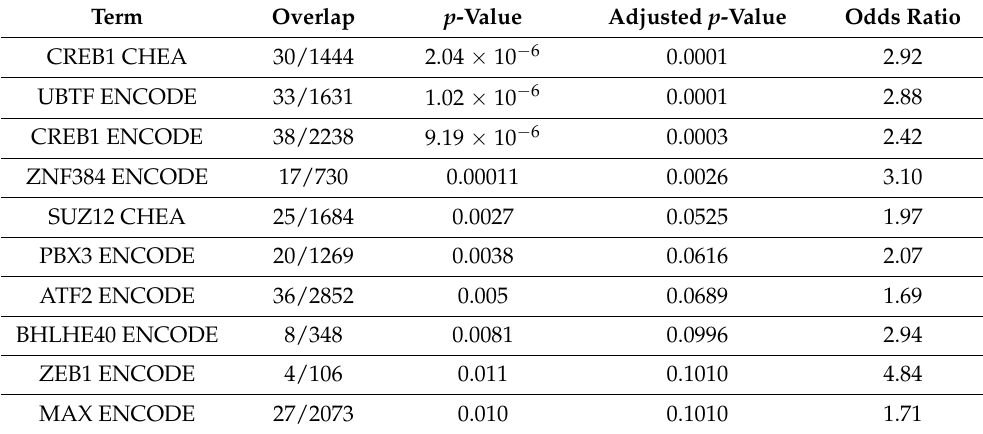
Table 4. Enriched transcription factor of the downregulated gene list from untreated RA CD8 + Tem cells.